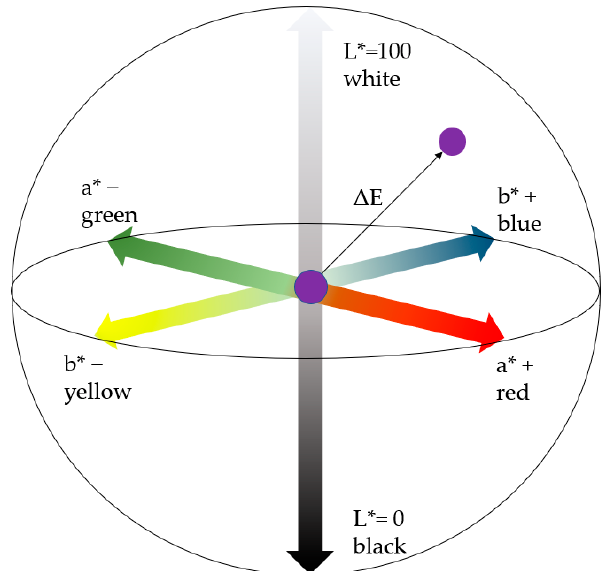
Figure 1. Graphic diagram of the quantitative coordinates used for meat color determination.